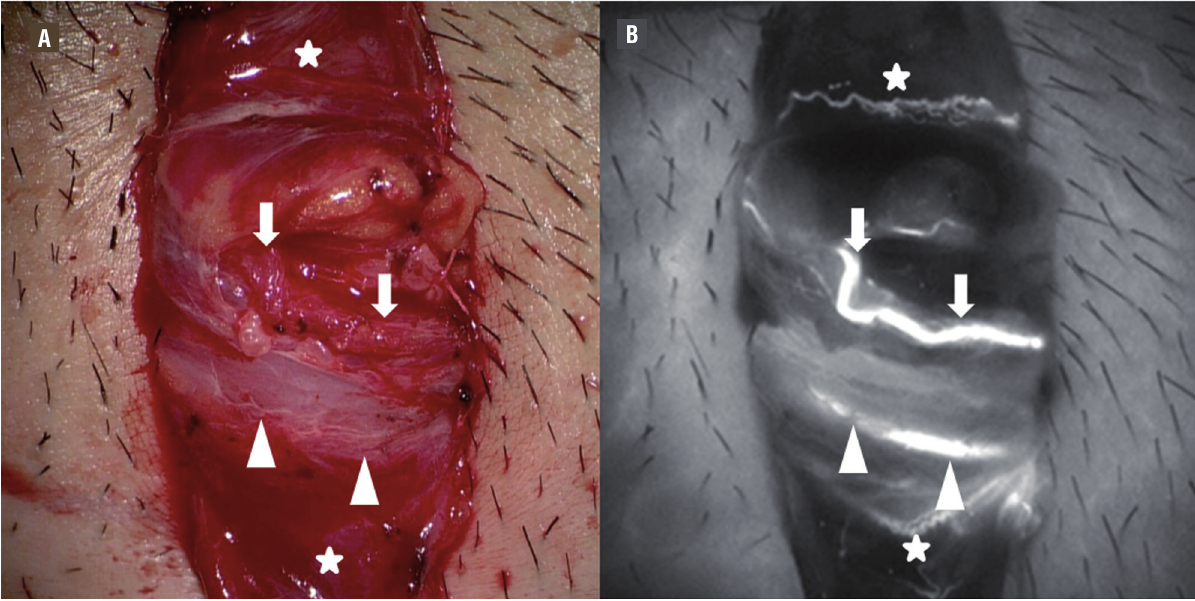
Figure 1 - Intraoperative images during microsurgical subinguinal varicocelectomy. A) Microscopic view before injection of indocyanine green. B) Indocyanine green angiography clearly demonstrated all the arterial supply to the testicle. The testicular artery was marked by arrows. Deferential artery and cremasteric arteries were denoted by arrow heads and stars